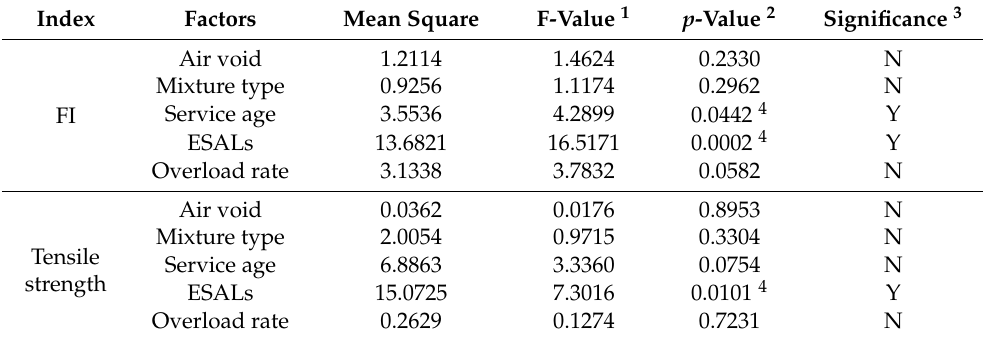
Table 2. ANOVA results of indices for the top layer.